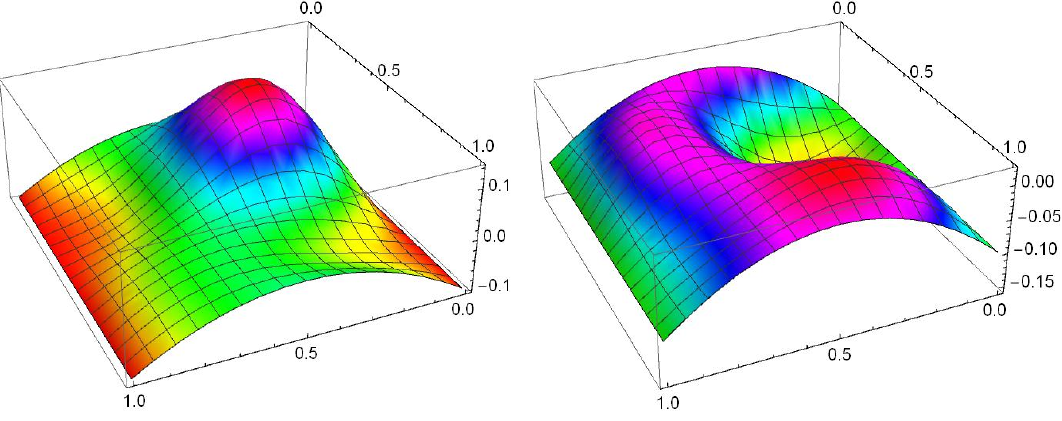
Figure 4: Superposition of the first four